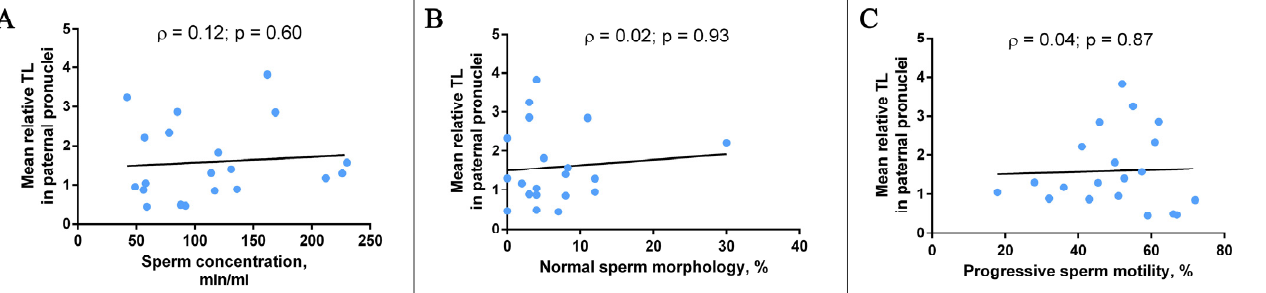
Figure 5. The relationships between telomere length (TL) in paternal chromosomes from human triploid zygotes and sperm parameters. Scatter plots of the mean relative TL in paternal chromosomes and sperm concentration ( A ), normal sperm morphology ( B ) and progressive sperm motility ( C ). In neither case did the Spearman test show a statistically significant correlation.